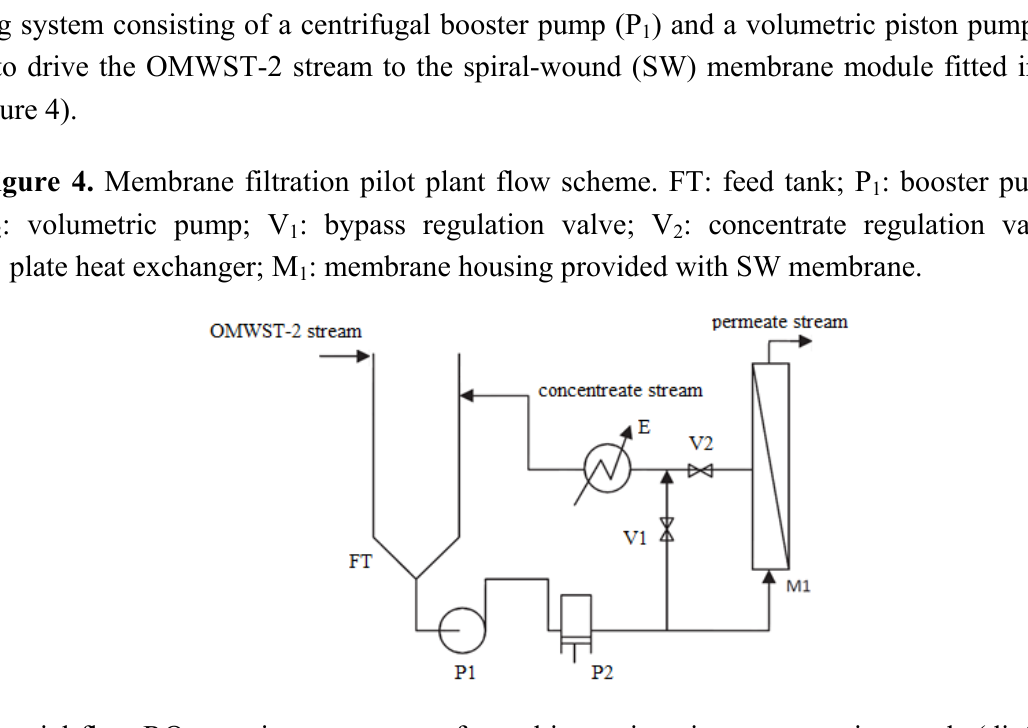
: booster pump; 1 : concentrate regulation valve; 2